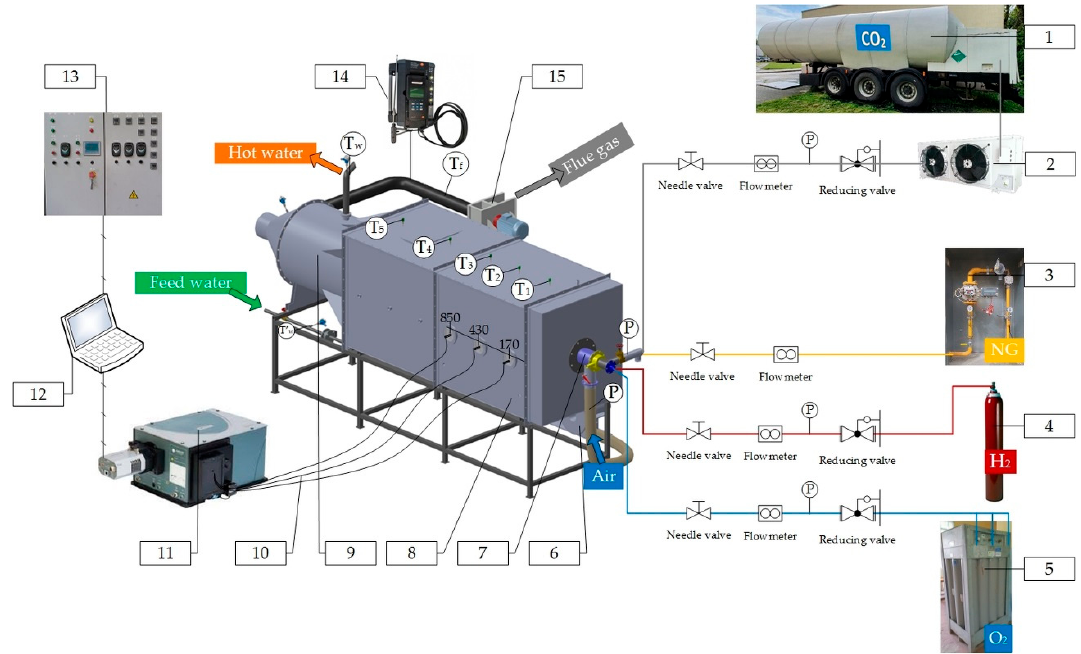
Figure 1. Scheme of the experimental burner testing setup: 1–A liquid CO2 tank; 2–a CO2 vaporizer;